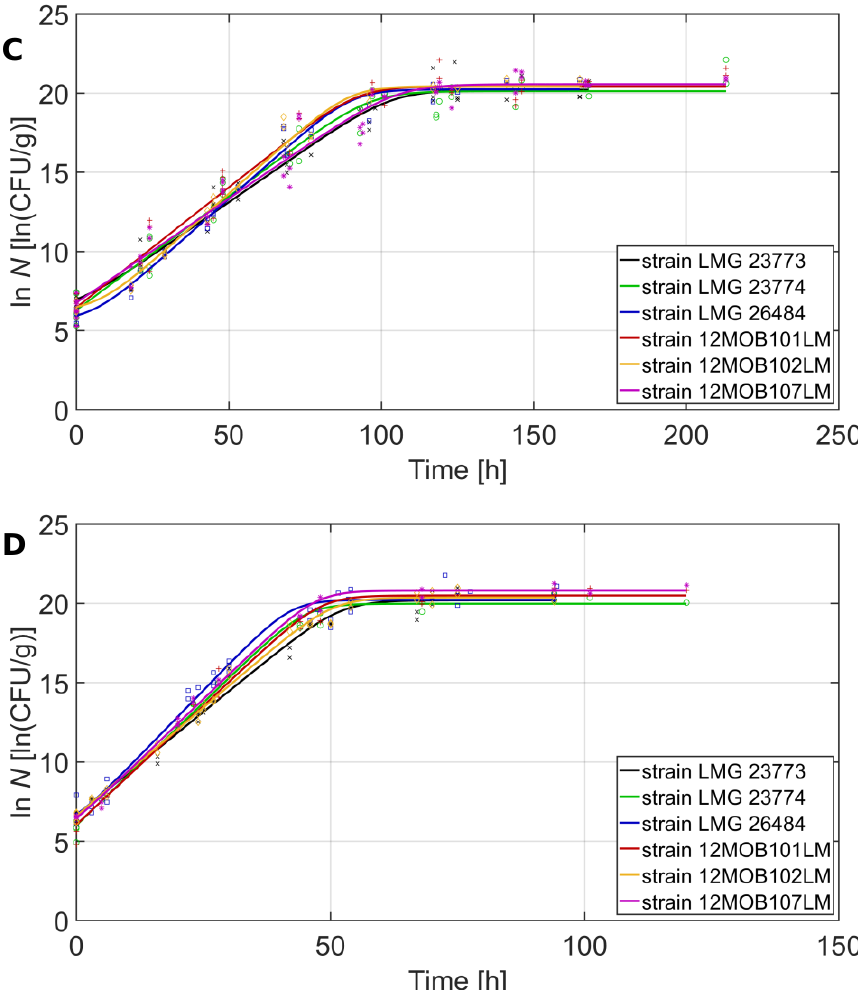
Figure 1. Growth of six L. monocytogenes strains in smoked salmon pâté at 2 ( A ), 8 ( B ), 14 ( C ), and 20 °C ( D ). The symbols (×, ○ , □, +, ◊, and ✳ for strains LMG 23773, LMG 23774, LMG 26484, 12MOB101LM, 12MOB102LM, and 12MOB107LM, respectively) represent the experimental data, and the lines correspond to the primary model fit [25].